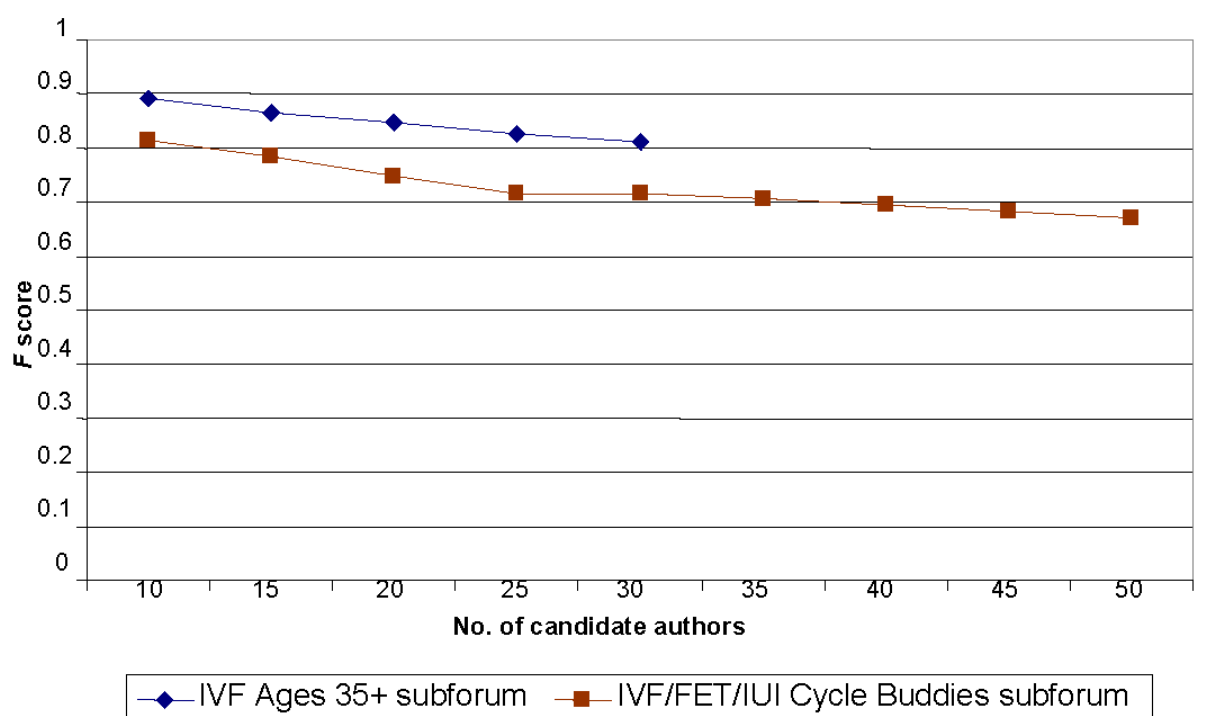
Figure 5. Dependency of the accuracy on candidate author number for author detection task on the IVF/FET/IUI Cycle Buddies and IVF Ages 35+ subforums.